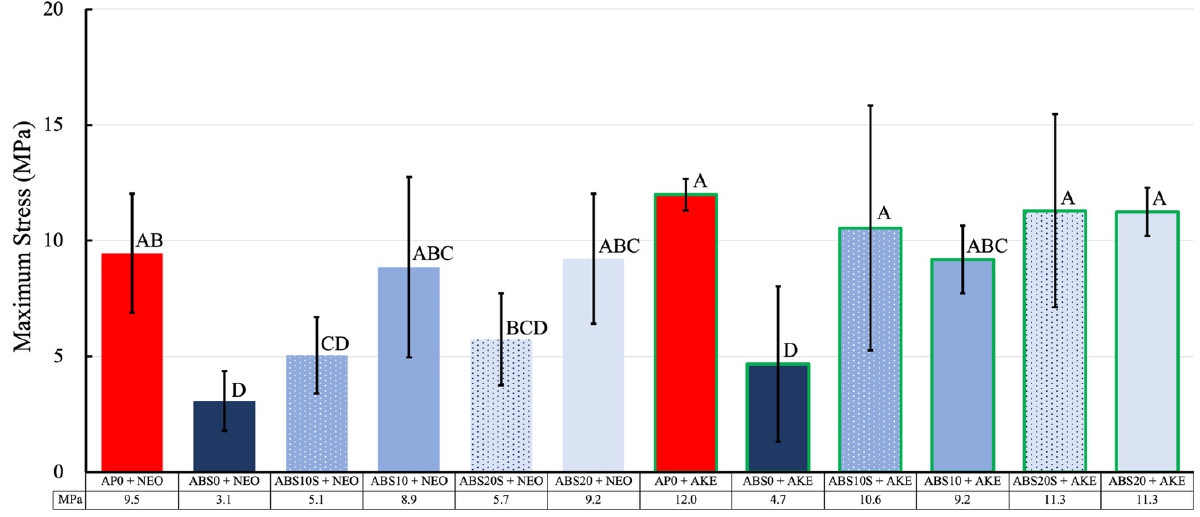
Figure 7. Maximum stress of various specimens obtained from the shock absorption test. The values of the same letter were not significantly different ( p > 0.05).